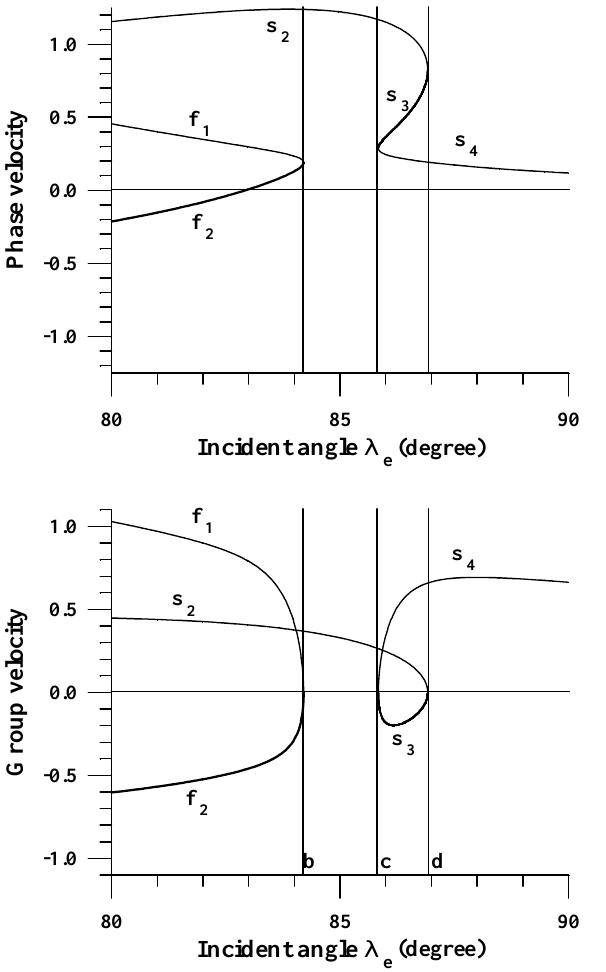
Fig. 8. Propagation angle of MHD waves versus the incident angle of entropy wave (the same as in Fig. 6 but for other characteristics of the fast shock